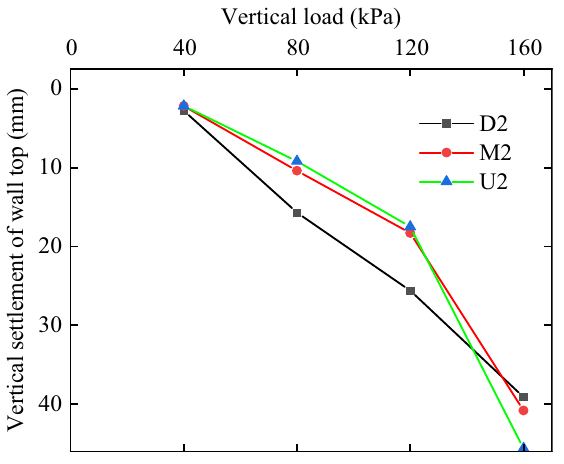
Figure 7: Vertical settlement of the wall